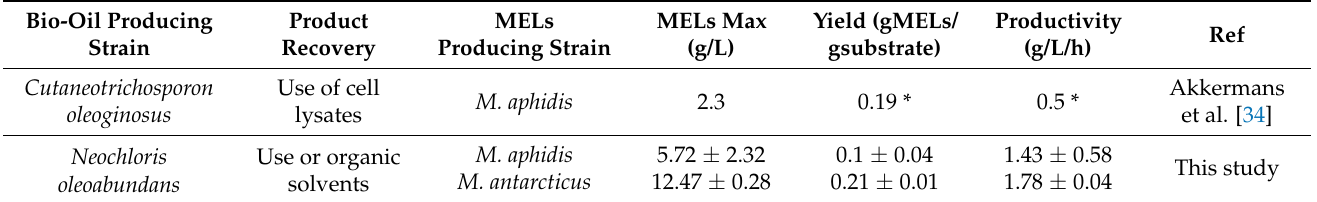
Table 3. Summary of the results obtained by Akkermans et al. [34] and the results here presented, that report on the use of two sequential microorganisms for the production of MELs, including type of strain, type of product, titre, yield and productivity. * Values are not present in the article and are calculated by